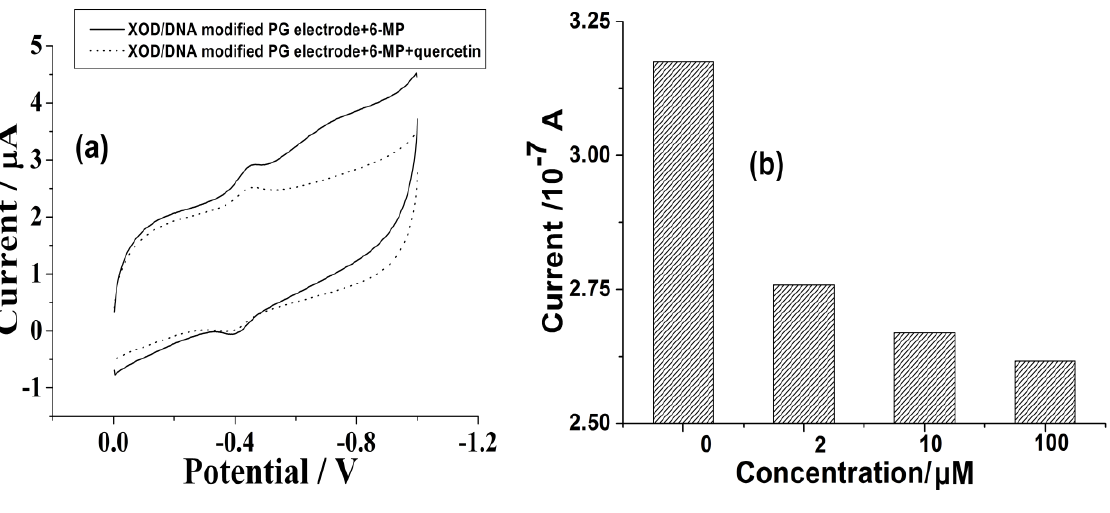
Figure 3. ( a ) Cyclic voltammograms obtained at XOD/DNA modified electrode for 200 μM 6-MP in the absence and presence of 200 μM quercetin, others same as in Figure 1; ( b ) The chronoamperometric currents obtained at the XOD/DNA modified electrode for 2 mM 6-MP in the presence of different concentrations of quercetin (0, 2, 10, 100 μM) in 0.1 M phosphate buffer (pH